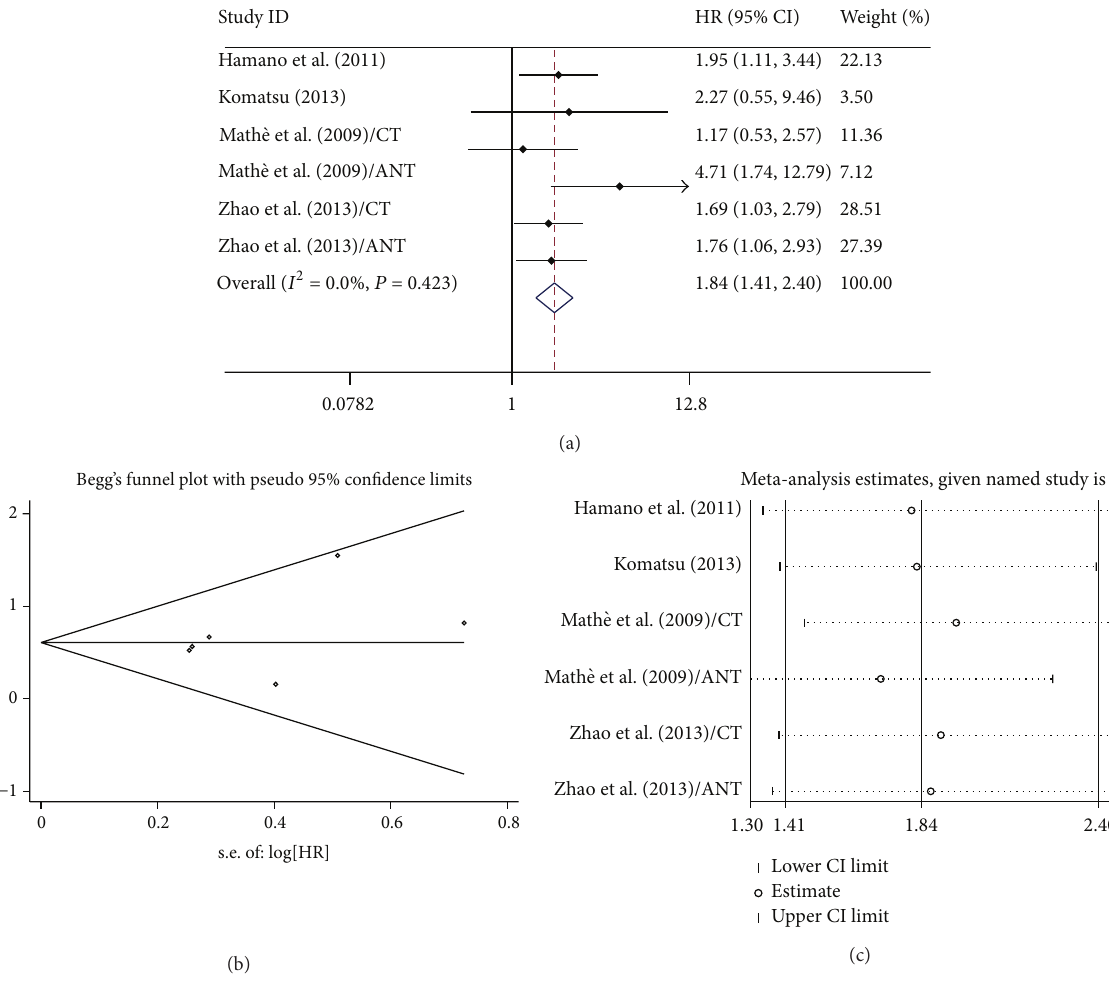
Figure 1: (a) Forest plots of studies evaluating HR of survivals comparing high and low miR-21 expression. (b) Funnel plots of publication bias for meta-analysis of miR-21. (c) Sensitivity analysis for meta-analysis of miR-21.